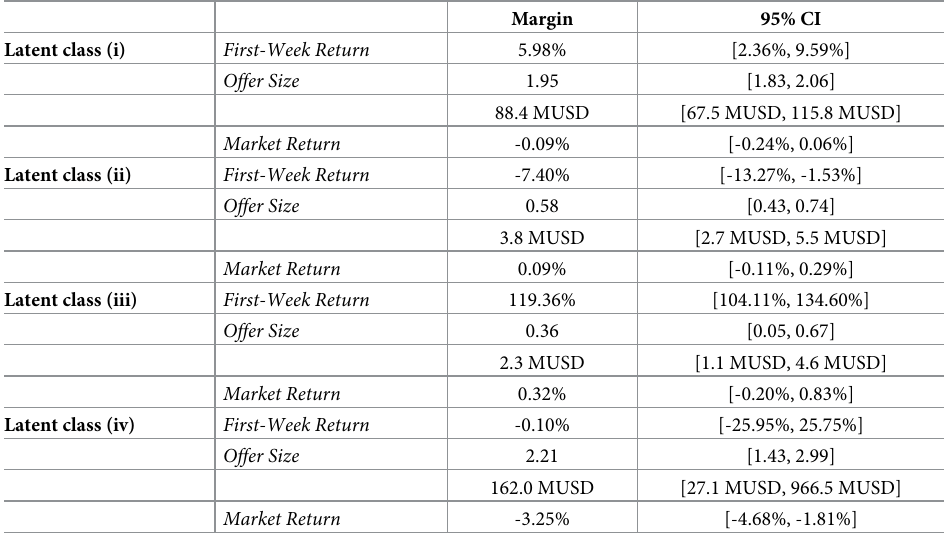
Table 6. Predicted latent class means using first-week returns on the issuing firms’